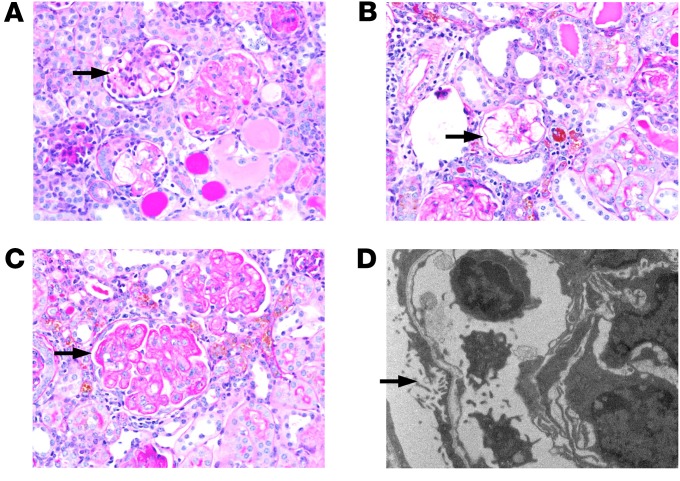
TMA in C3KI mice.PAS-stained sections from C3KI mice aged 14–28 days. Images are representative of the 8 C3KI mice examined. Arrows highlight key examples of the following: (A) Mesangiolysis in the glomerulus. (B) Microaneurysms of the glomerular capillaries following dissolution of the matrix after the mesangiolysis. (C) Double contouring of glomerular capillary walls, a key feature of chronic TMA. Original magnification in A–C, ×40. (D) Electron microscopy (original magnification, ×7900) showing subendothelial lucency, which is consistent with ischemic conditions precipitated by the TMA from a day 7 C3KI mouse.